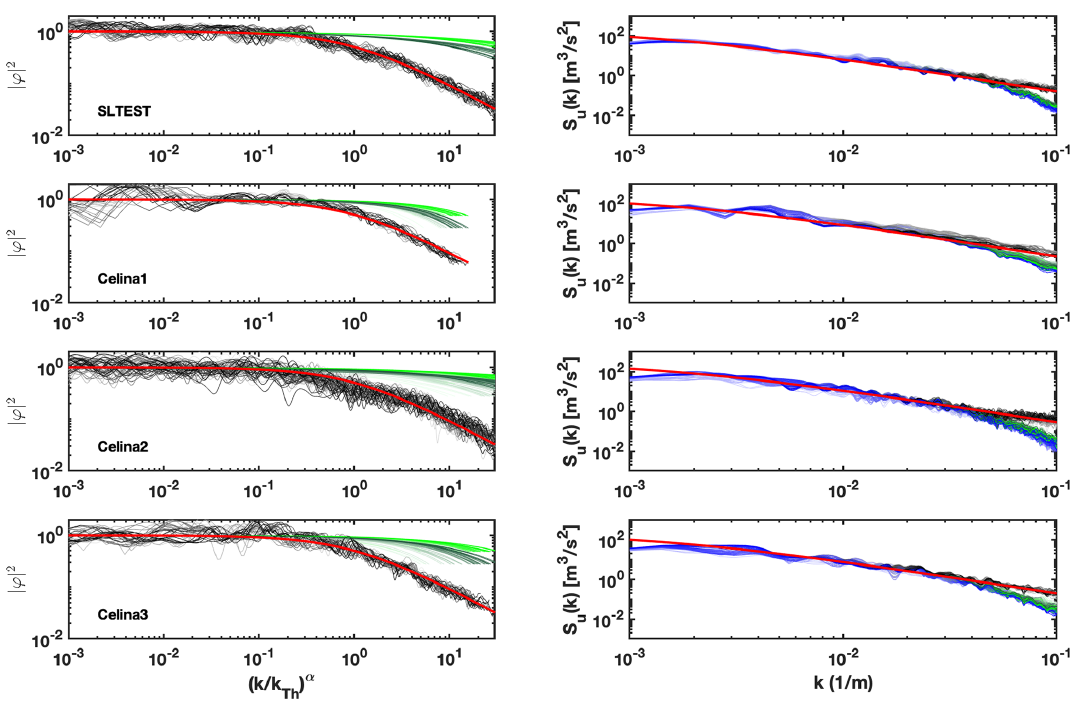
Figure 10. Correction of the lidar spectra. Left column: the black lines are ϕ 2 ∗ and the red line is the fitted low-pass filters of Eq. (9) for the highest range gate. Dark and light green lines represent the transfer function predicted by Eqs. (5) and (6). Right column: the blue lines are raw lidar spectra, the dark and light green lines are lidar spectra corrected with Eqs. (5) and (6), respectively, the red line is the fitted Kaimal spectrum for the highest range gate, and the black lines are the lidar spectra corrected with the proposed procedure of Fig. 1. Line colors become darker with increasing